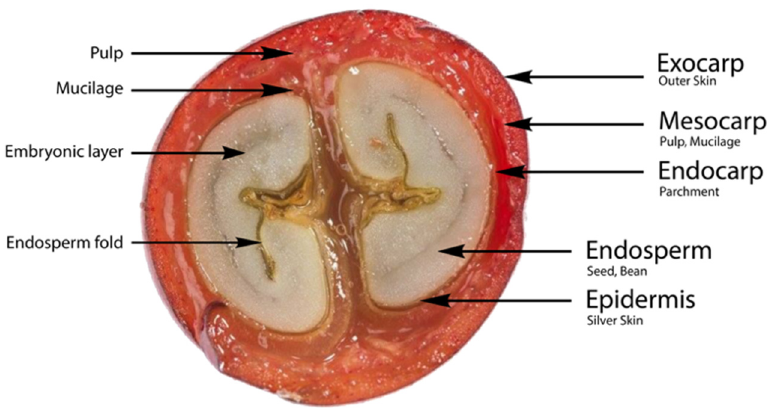
Figure 1. The anatomy of the cherry coffee bean. Coffee cherry fruit consists of an exocarp, mesocarp, endocarp, silver skin, and en- dosperm (bean). The outer skin, or exocarp, is also referred to as the peel, the outermost layer of the coffee fruit. It is formed by a single parenchyma cell, with the primary